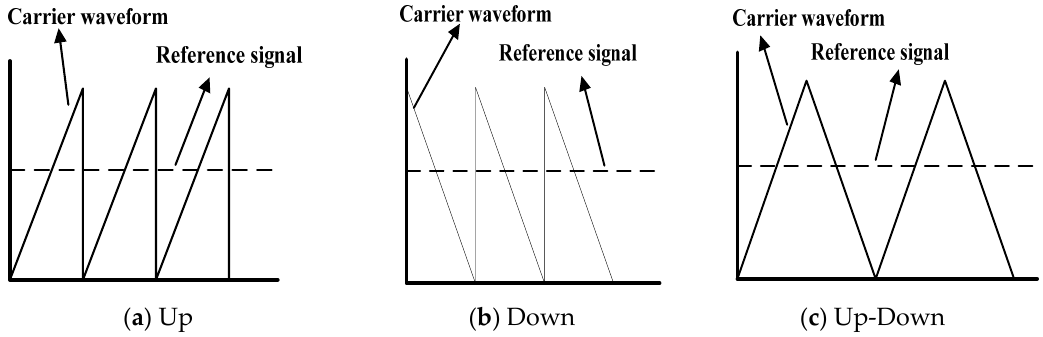
Figure 9. The different counting mode waveforms. ( a ) up; ( b ) down and ( c ) up ‐ down